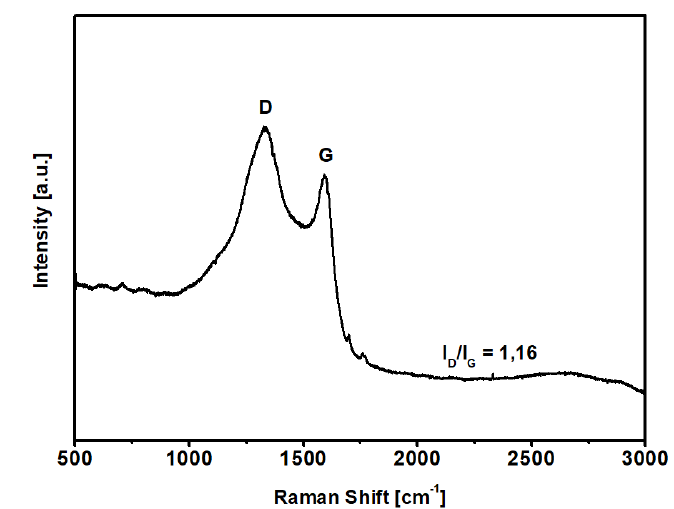
Figure 3. Raman spectrum of the carbon sample in the region 3000–500 cm − 1